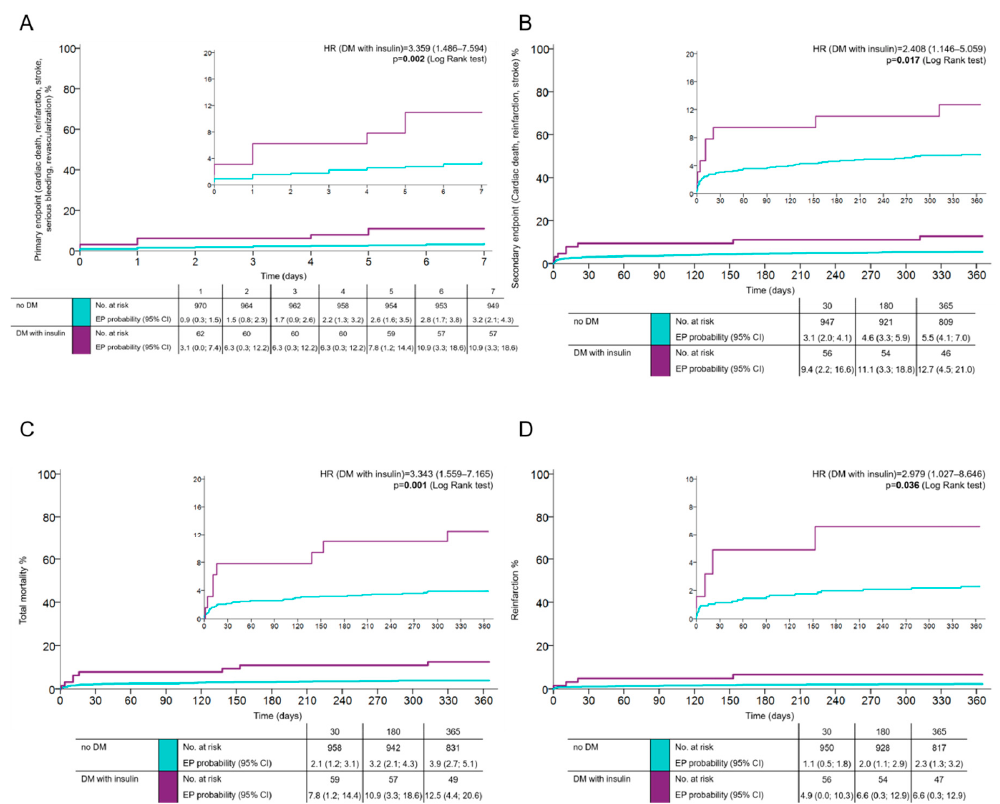
Figure 2. Patients with DM on insulin therapy compared to patients without DM, following acute myocardial infarction (AMI) treated with primary percutaneous coronary intervention and prasugrel or ticagrelor. The occurrence of ( A ): the primary key efficacy endpoint (cardiovascular death, spontaneous re-infarction, stroke, serious bleeding, and revascularization at 7 days), ( B ): the secondary endpoint (cardiovascular death, spontaneous re-infarction, and stroke at 1 year), ( C ): total mortality at 1 year, ( D ): and reinfarction at 1 year (time-to-event analysis was done using the Kaplan–Meier estimate of the survival function).